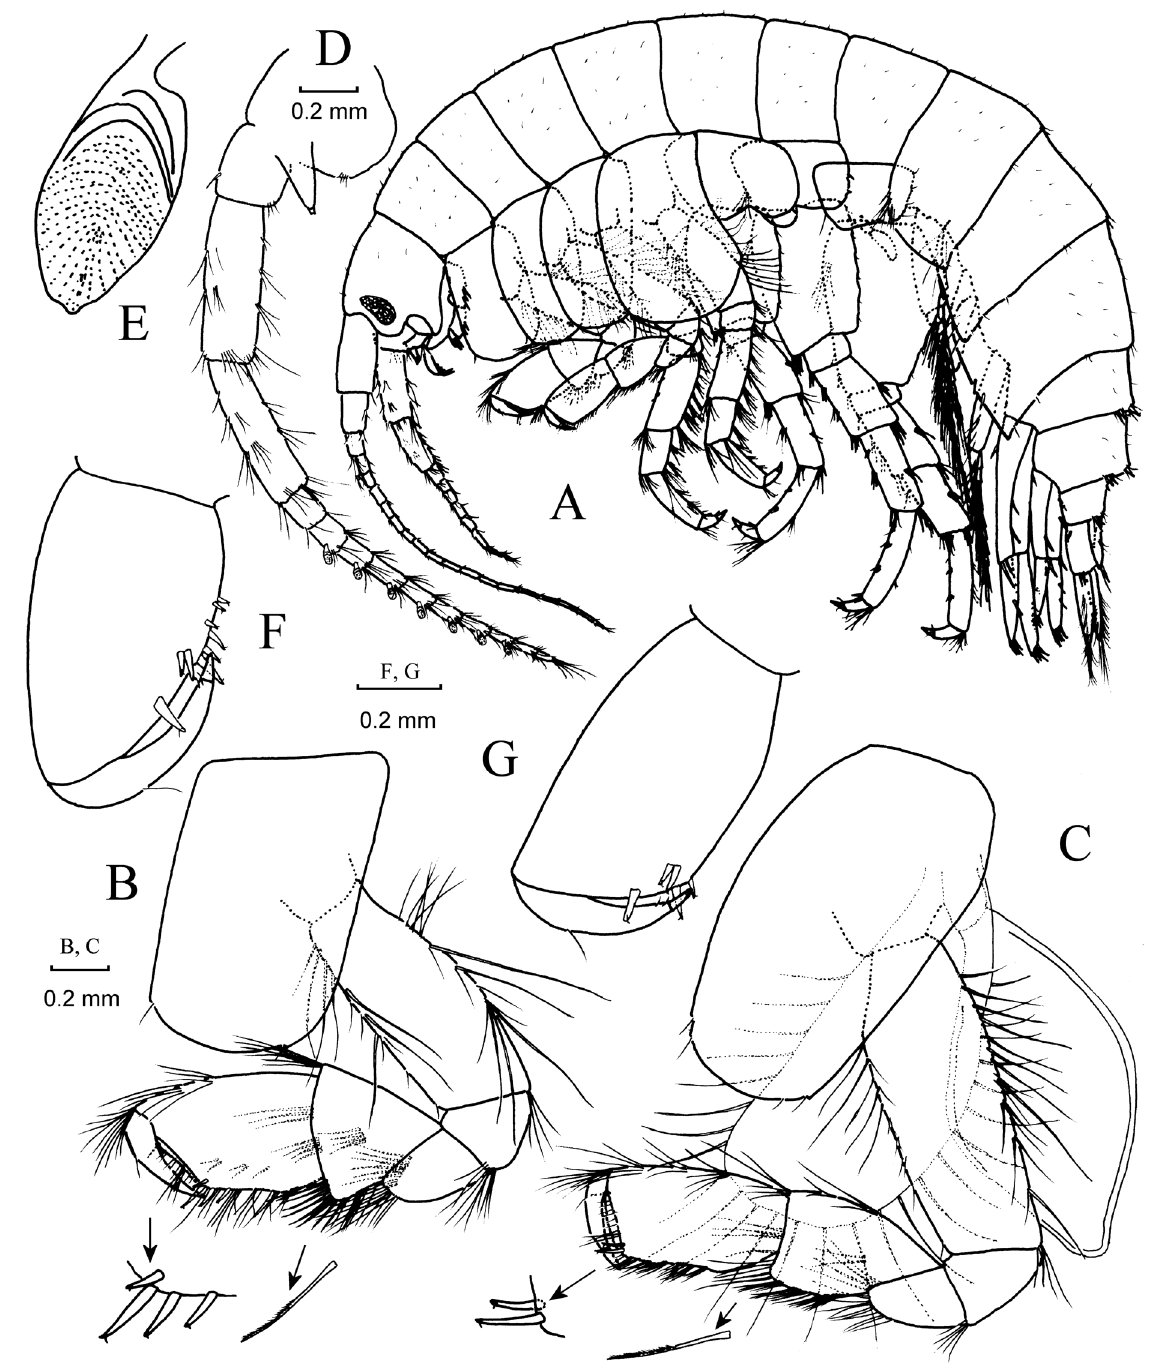
Fig. 2. Gammarus koshovi (Bazikalova, 1946), DAS 16-013. A–C . ♀, 8.0 mm. A . Habitus, lateral view. B . Gnathopod I. C . Gnathopod II. — D–G . ♂, 7.5 mm. D . Antenna II. E . Antenna II, calceolus (× 2800). F . Gnathopod I, setation omitted. G . Gnathopod II, setation